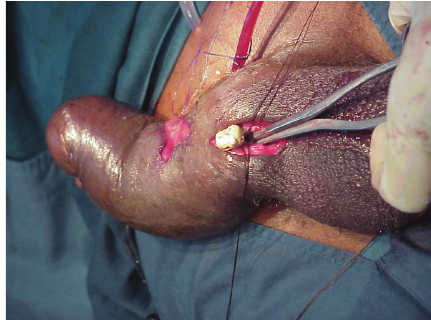
Figure 4: Multiple extracted urethral